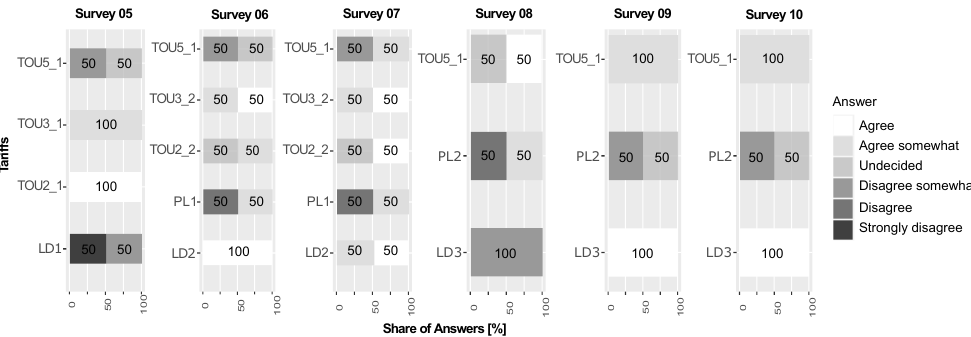
Figure 9. Assessment of the potential financial benefit, comparing various electricity tariffs during the residential